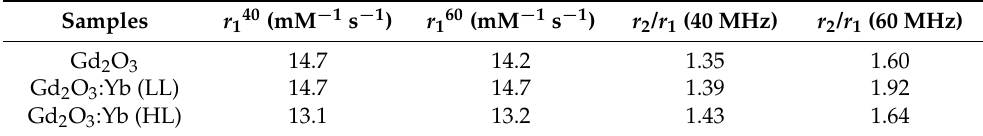
Table 1. The r 1 and r 2 / r 1 ratio values per gadolinium ion measured at 40 and 60 MHz (310 K).